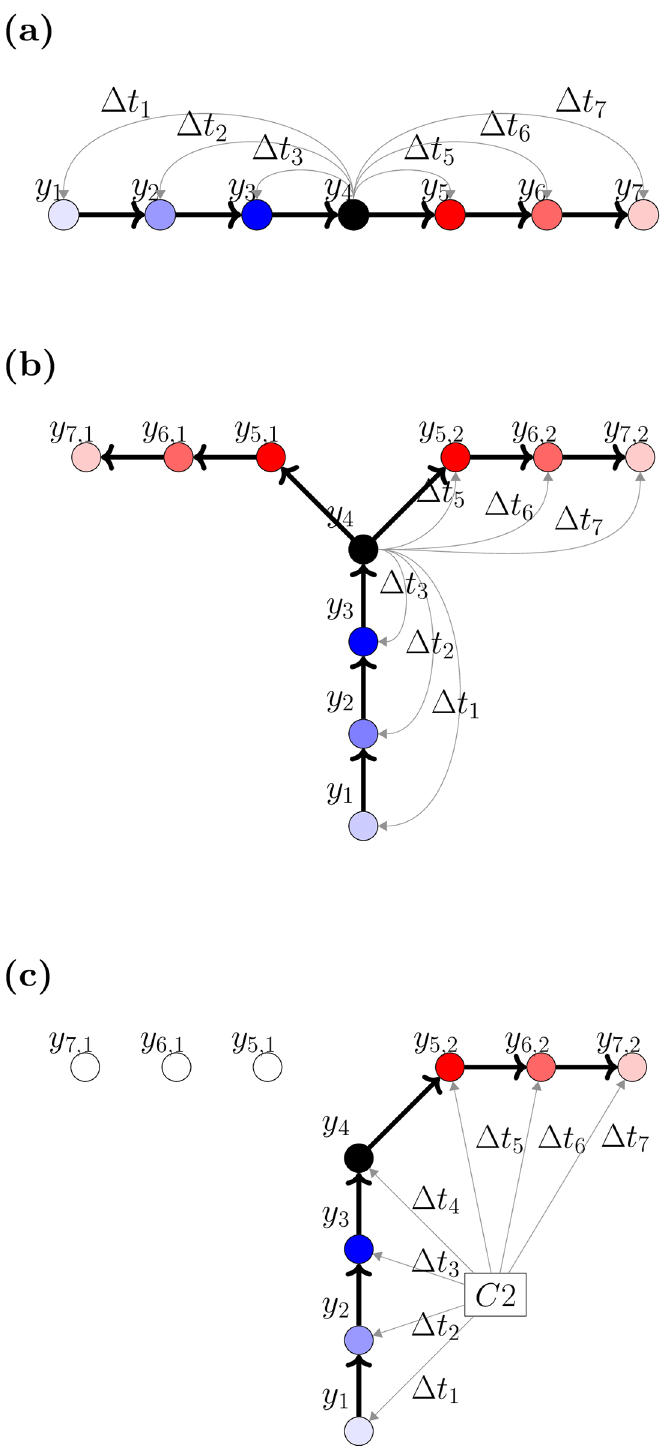
Fig 4. Schematic illustration of the changes of coupling strengths caused by STDP. Connection strengths from the black neuronto the neuronsin blue are decreased, whilst those in red are increased. Color intensity is proportional to the magnitudes of the changesin couplingstrengths. Thick arrows show the path of a neuralsequence,and thin grey arrows show the connections of interest. (a) The effect of propagationof a sequenceand STDP on recurrent connections. Connectionsin the direction of propagationof the